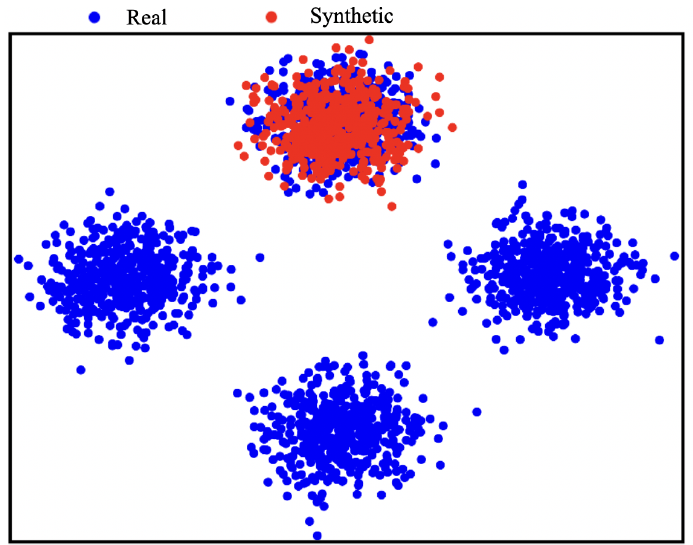
Figure 9. Graphical representation of mode collapse in a toy dataset consisting of random samples drawn from four Gaussian distributions with the same covariance matrix but different means (visible by the four separate clusters). The blue points correspond to real data points, whereas the red ones are synthesized by the generator. The generator has found a small number of samples (the ones in the upper cluster), so it does not learn beyond that. It will continue to produce samples in that range without seeing the overall distribution of the data, as it is enough to fool the